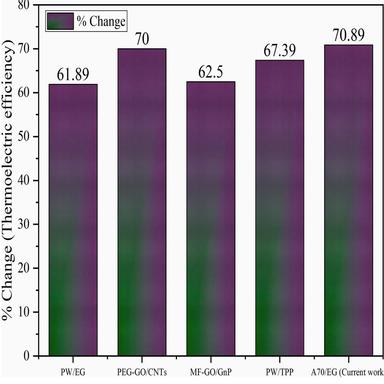
Schematic diagram of comparative analysis of SSPCM composites.